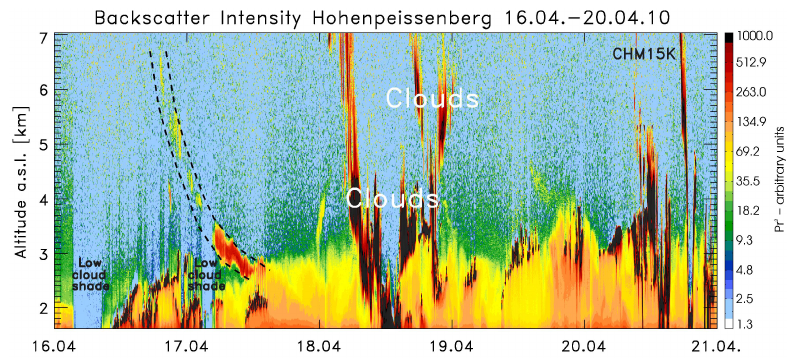
Fig. 1. Time series of ceilometer backscatter profiles at Hohenpeissenberg from 16 to 20 April 2010. Low clouds are often hampering the observation of higher layers above while the arrival and entrainment of the main ash plume into the PBL (indicated by dashed lines) could be observed during a mostly cloud-free period. Thin ash layers are evident also on 18 April, ≈ 00:00 UT (3–4km) and on 19 April all the day (most pronounced ≈ 00:00 UT in 3–4km and in the afternoon around 4km.